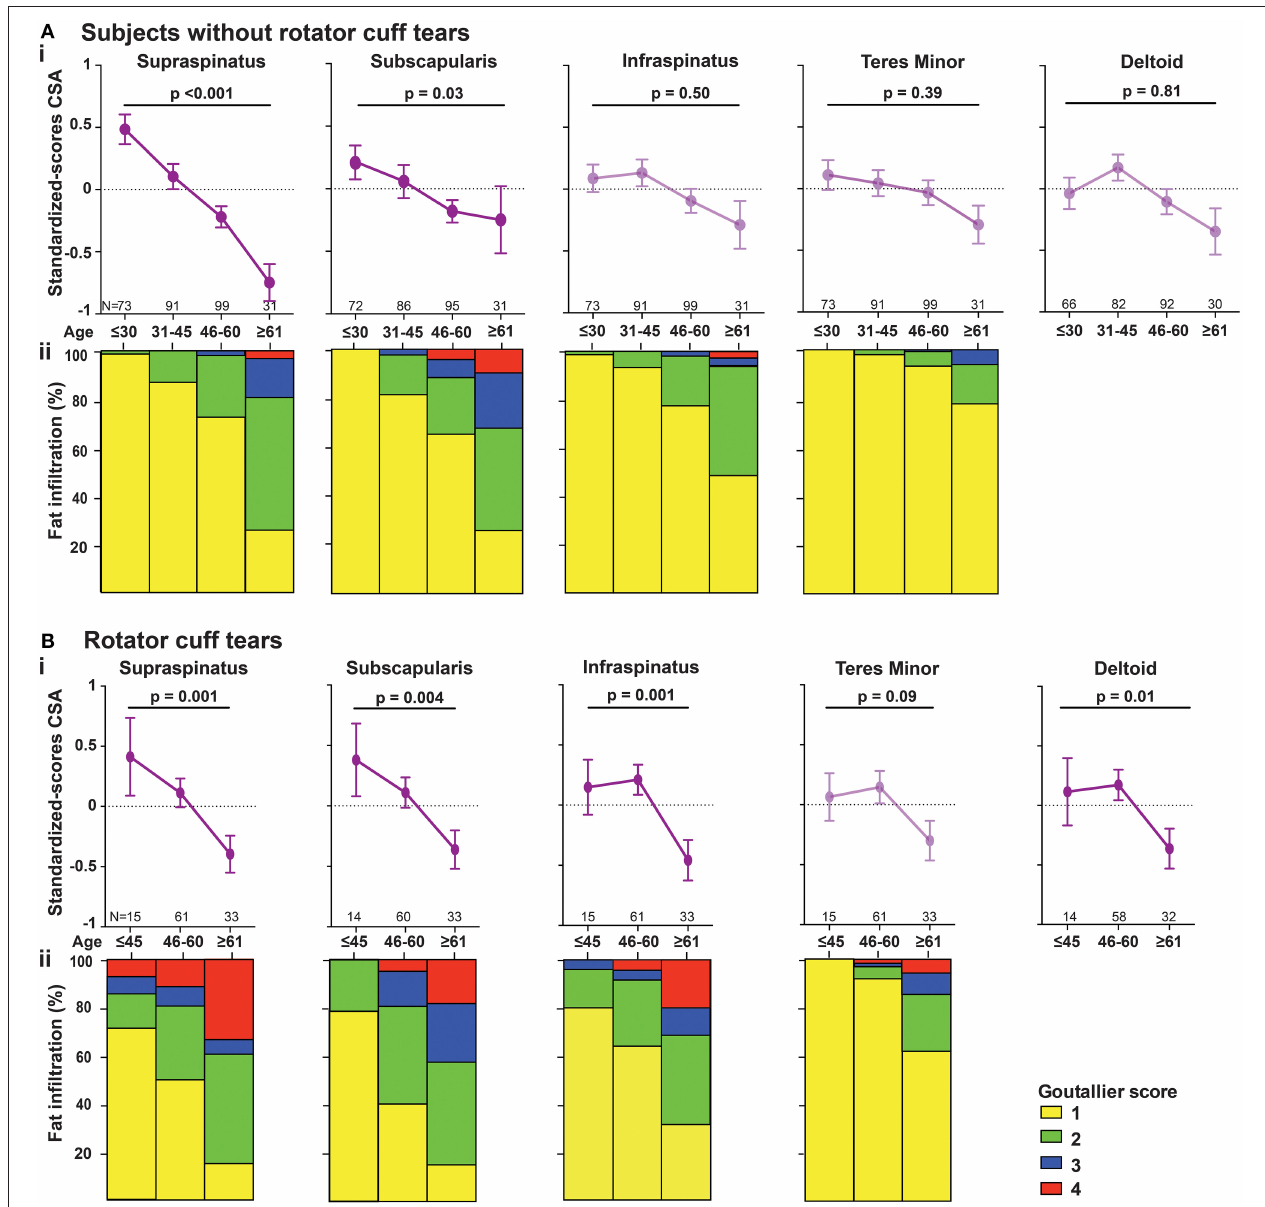
FIGURE 2 | Age-associated changes in muscle cross sectional area and fatty infiltration in shoulder muscles. Age-associated analyses were performed in five shoulder muscles (supraspinatus, subscapularis, infraspinatus, teres minor, and deltoid) in subjects without RC-tear (A) and in RC-tear (B) . ( i ) Age-associated trends of standardized muscle cross-sectional surface areas. p -values for age-association were calculated using linear regression and are adjusted for gender. Significant trends are depicted in dark purple, non-significant trends are depicted in light purple. ( ii ) Age-associated increase in fatty infiltration. Fatty infiltration was evaluated according to the Goutallier